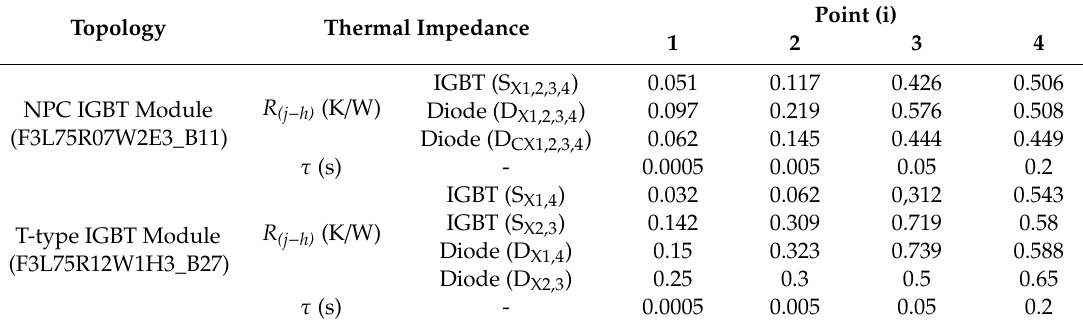
Figure 6. The thermal equivalent block diagram of a part of the IGBT module with a Foster model. Table 2. Parameters for a 30 kW PV Inverter system.